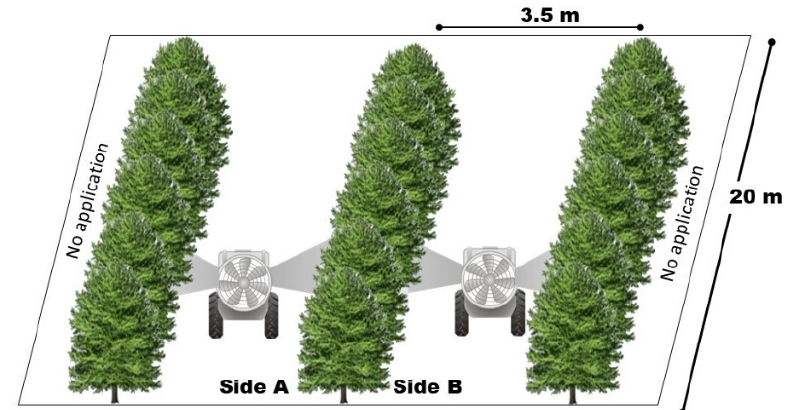
Figure 6. The plot dimensions for the coffee crops.